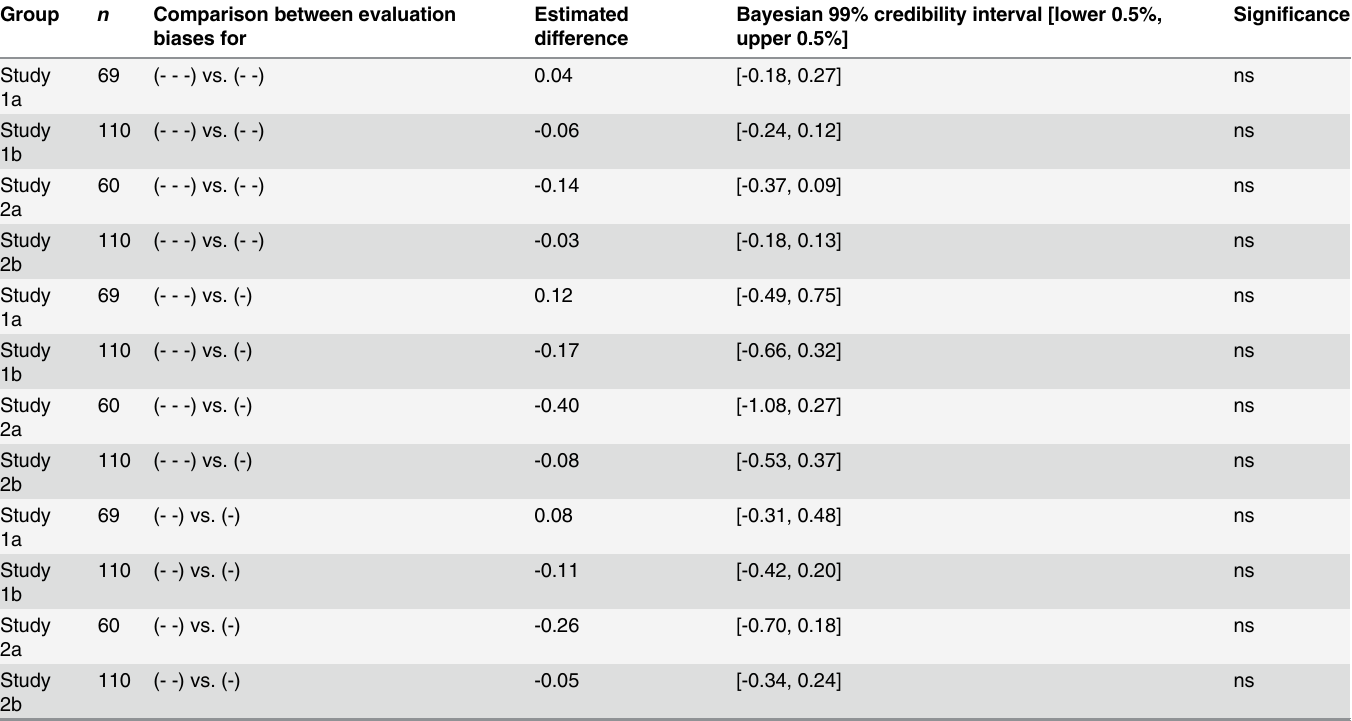
Table 3. Pairwise comparisons between attitudinal evaluation biases within the con-arguments. ns: Bayesian 99% credibility interval contains the value of zero (not significant). Group